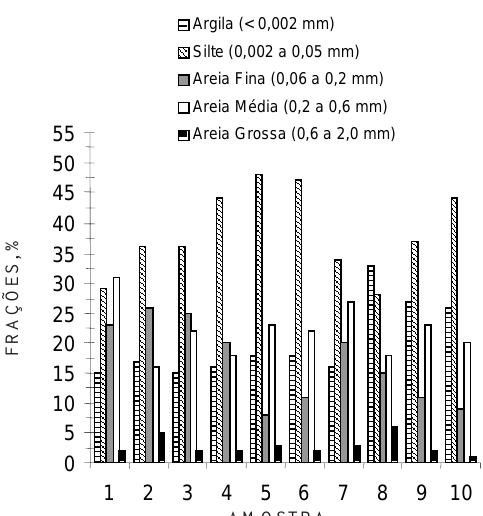
Figura 2. Distribuição granulométrica com uso de